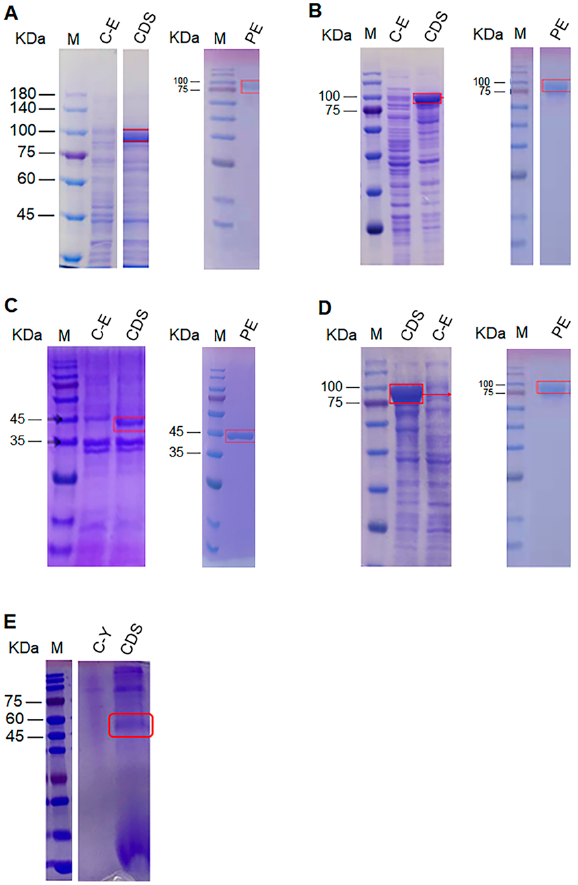
Figure 1. Expression and purification of the ACO proteins from straw mushrooms and oyster mushrooms. ( A ), VvACO1; ( B ), VvACO2; ( C ), VvACO3; ( D ), VvACO4; ( E ), PoACO. M, protein marker; C-E, control E. coli cell extract; CDS, cell disruption supernatant; C-Y, control yeast cell extract; PE, purified